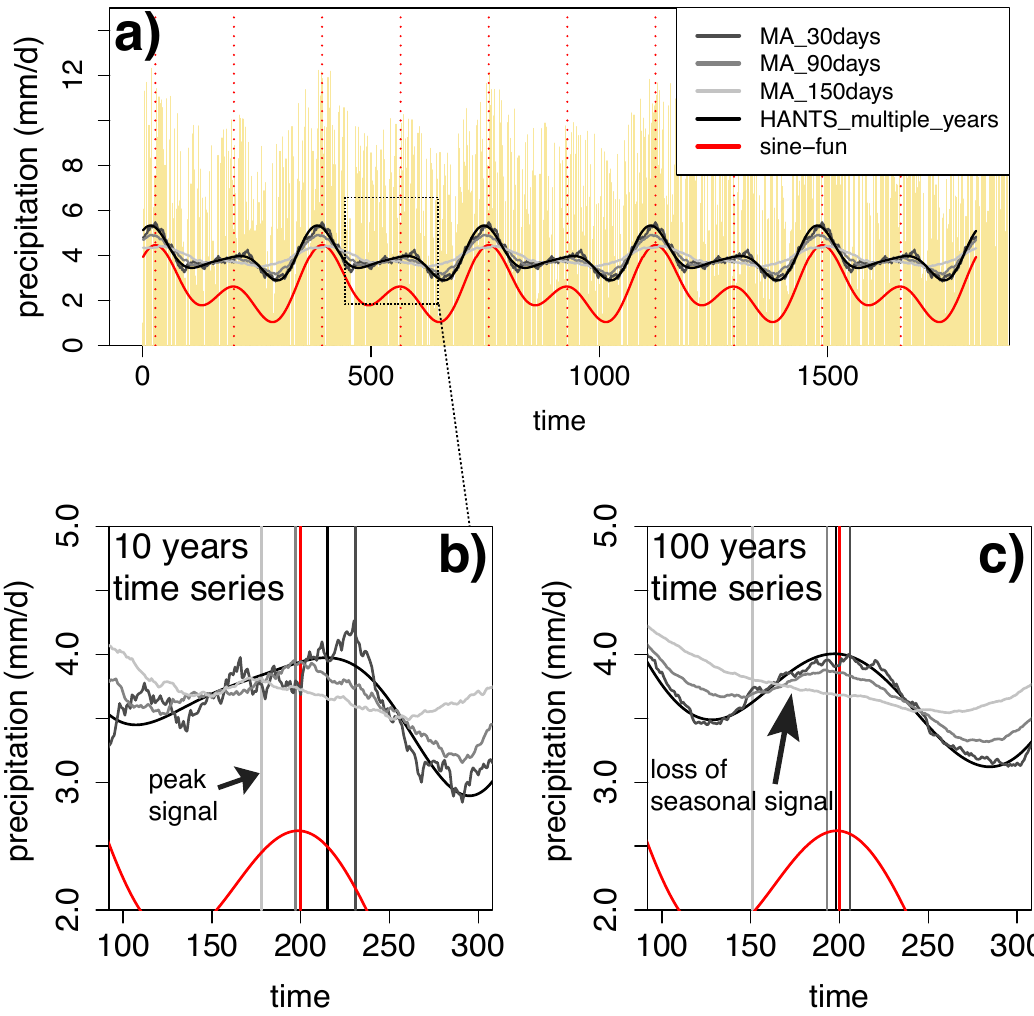
Figure 3. Comparison of HANTS and moving averages (MA). ( a ) Synthetic time series of precipitation data (yellow) based on two added sine functions with frequencies of 2 π and 4 π per year and a phase offset to model a signal similar to possible bi-modal curves with a winter and a summer peak (red curve). Noise added by (1) means of a uniform distribution with values between 0 and 8 and (2) additional random removal of individual values. ( b ) Different MA with varying window sizes applied to mean daily values of the generated time series with a 10-year period. Displayed HANTS (“full series”) is based on the same time series. ( c ) Same as for (b), but based on time series of 100 years. Vertical bars indicate the maximum of individual curves within a 100-day window around the actual maxima of the original overlain sine